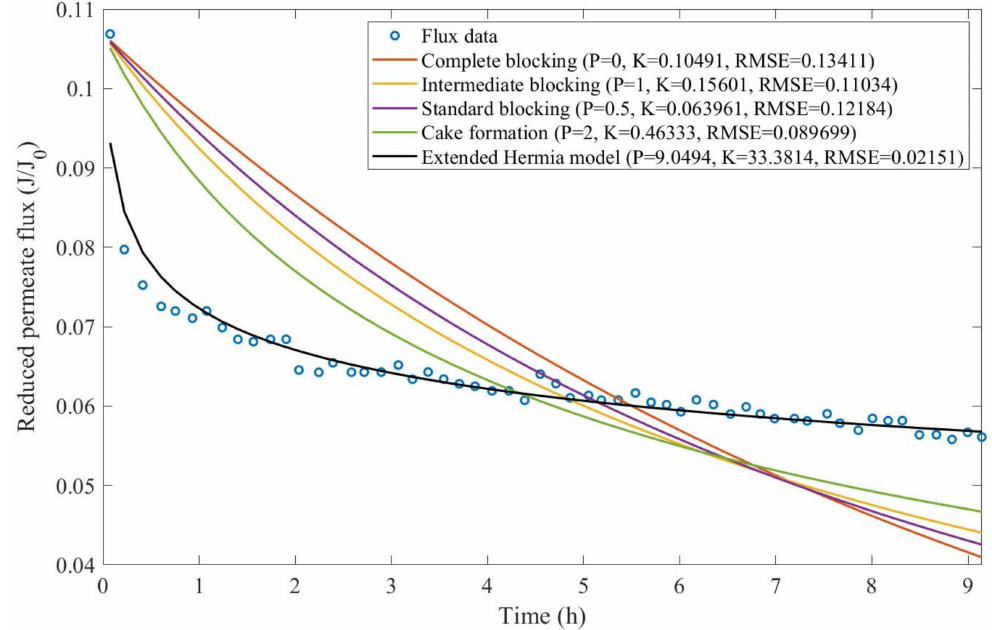
Figure A29. Model fitting for ultrafiltration of flooding wastewater at 2.20 bar and cross-flow velocity of 3.00 m/s considering the four original pore blocking mechanisms and the extended Hermia model